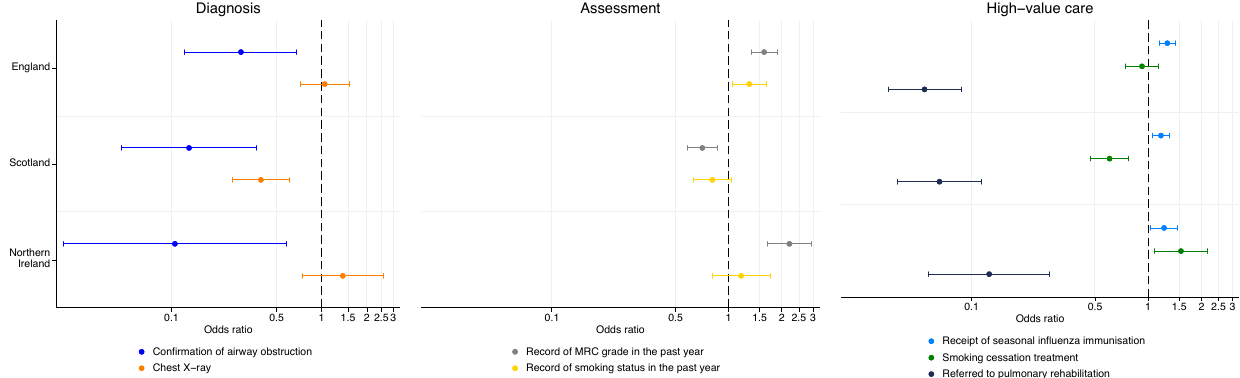
Fig. 2 Fully adjusted odds ratios and 95% con fi dence intervals for receipt of item of COPD care (split into diagnosis, assessment, and high- value care) for each UK country relative to Wales. MRC Medical Research